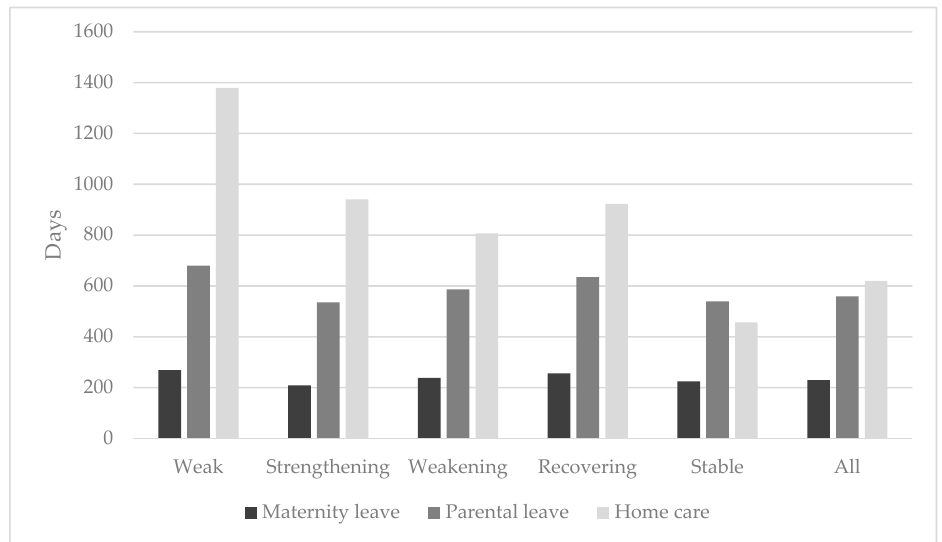
Figure 3. Mother’s family leave days by trajectory group and type of family leave (total of days 2005–2016).